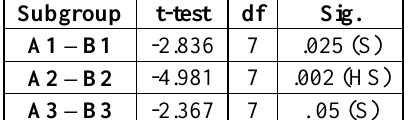
Table 5: Student t-test to study the effect of the type of adhesive on the marginal gap